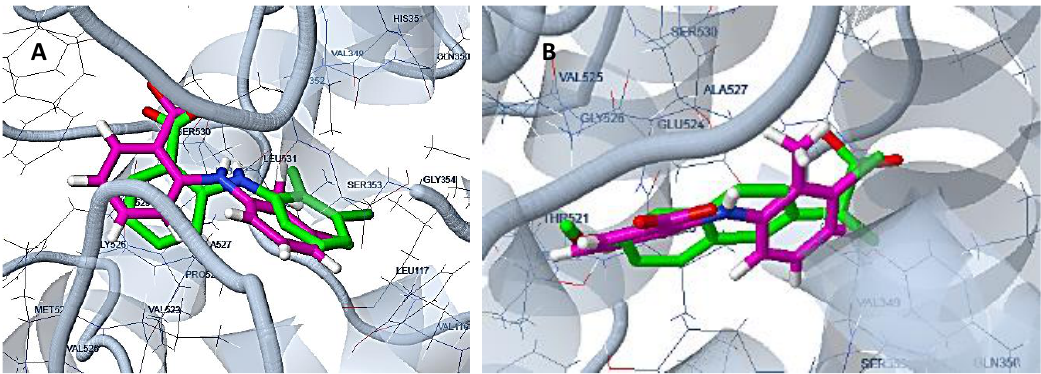
Figure 9. Docking of tolfenamic acid ( A ) and naproxen ( B ) to the structure 5IKT of human COX-2, Energy: − 7.04 kcal / mole (docked molecule in green, initial molecule in magenta).